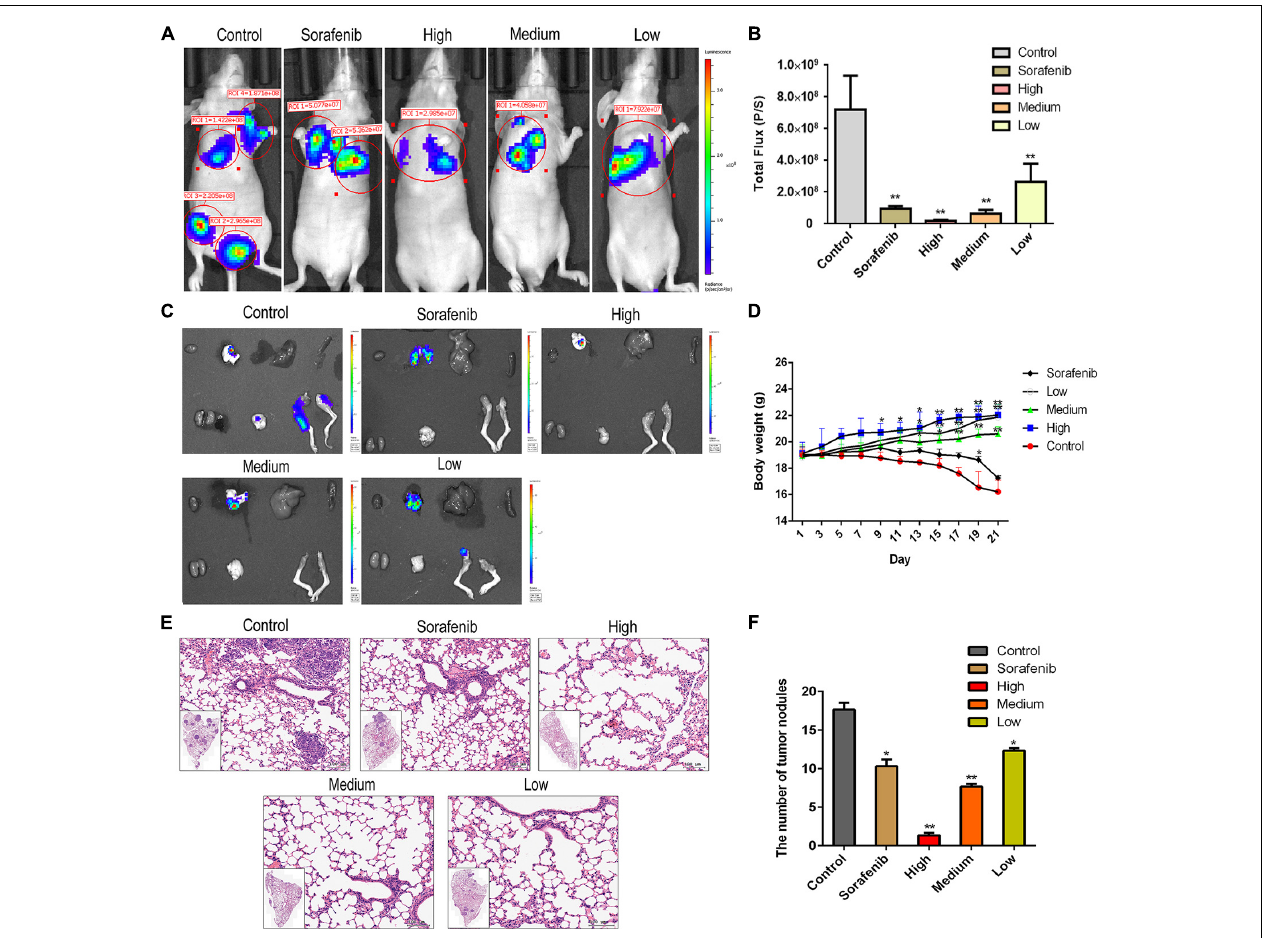
FIGURE 4 | AAEO treatment inhibits the lung, brain, and femur metastases of HCC cells in nude mice. Two weeks after inoculation with HepG2-Luc cells, tumor-bearing nude mice were treated with AAEO (57.5, 115, and 230 mg/kg) or sorafenib (40 mg/kg) for 21 days. (A) Representative bioluminescence imaging tracer results of nude mice at the end of study. (B) Quantification of bioluminescence imaging signal intensities in nude mice ( n = 5 per group). (C) IVIS imaging performed on nude mice tissues after dissection. (D) Body weight of tumor-bearing mice from different groups during treatment period. (E) Representative H&E-stained histologic images of tumor sections. (F) The number of lung metastatic nodules. *p < 0.05 and **p < 0.01 vs. the control